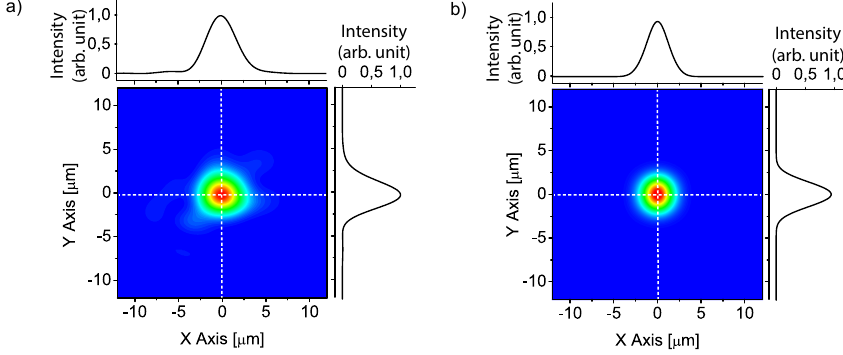
Figure 6. Focal spot ( a ) calculated from wavefront measurement by back-propagation; and ( b ) calculated from ray-tracing